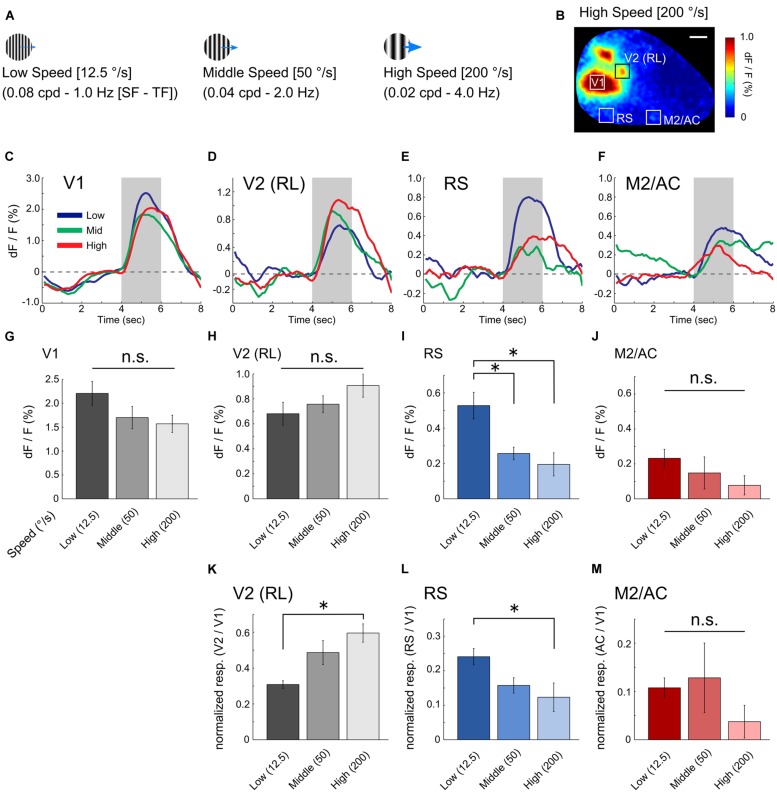
Visual response properties in V1, RS, and M2/AC. (A) Schematics of drifting gratings with three spatiotemporal frequency parameters. (B) An example of the visual response to high speed gratings. (C–F) Averaged time courses of V1, V2 (RL), RS, and M2/AC in the representative animal. (G–J) Averaged signal changes in visual response to three gratings in V1 (G, from left to right, 2.208 ± 0.251%, 1.701 ± 0.234%, 1.570 ± 0.181%), RL (H, 0.680 ± 0.092%, 0.757 ± 0.067%, 0.906 ± 0.093%), RS (I, 0.528 ± 0.075%, 0.257 ± 0.036%, 0.195 ± 0.066%), and M2/AC (J, 0.232 ± 0.051%, 0.148 ± 0.092%, 0.077 ± 0.055%). (K–M) Normalized response in the RL (K, 0.308 ± 0.022, 0.487 ± 0.067, 0.596 ± 0.051), RS (L, 0.241 ± 0.023, 0.158 ± 0.022, 0.123 ± 0.041), and M2/AC (M, 0.108 ± 0.020, 0.128 ± 0.072, 0.03 ± 0.034). Averaged across animals (n = 6 mice). Error bar: SE, ∗p < 0.05, n.s.: non-significant by ANOVA and post hoc Tukey’s HSD test. Scale bar in (B): 1 mm.